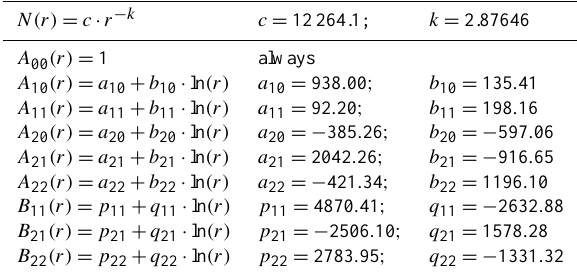
Table 1. Solar minimum 2008 and 2010 model fit coefficients. The A lm and B lm coefficients (with the exception of A 00 ) have to be multiplied by 10 − 4 .